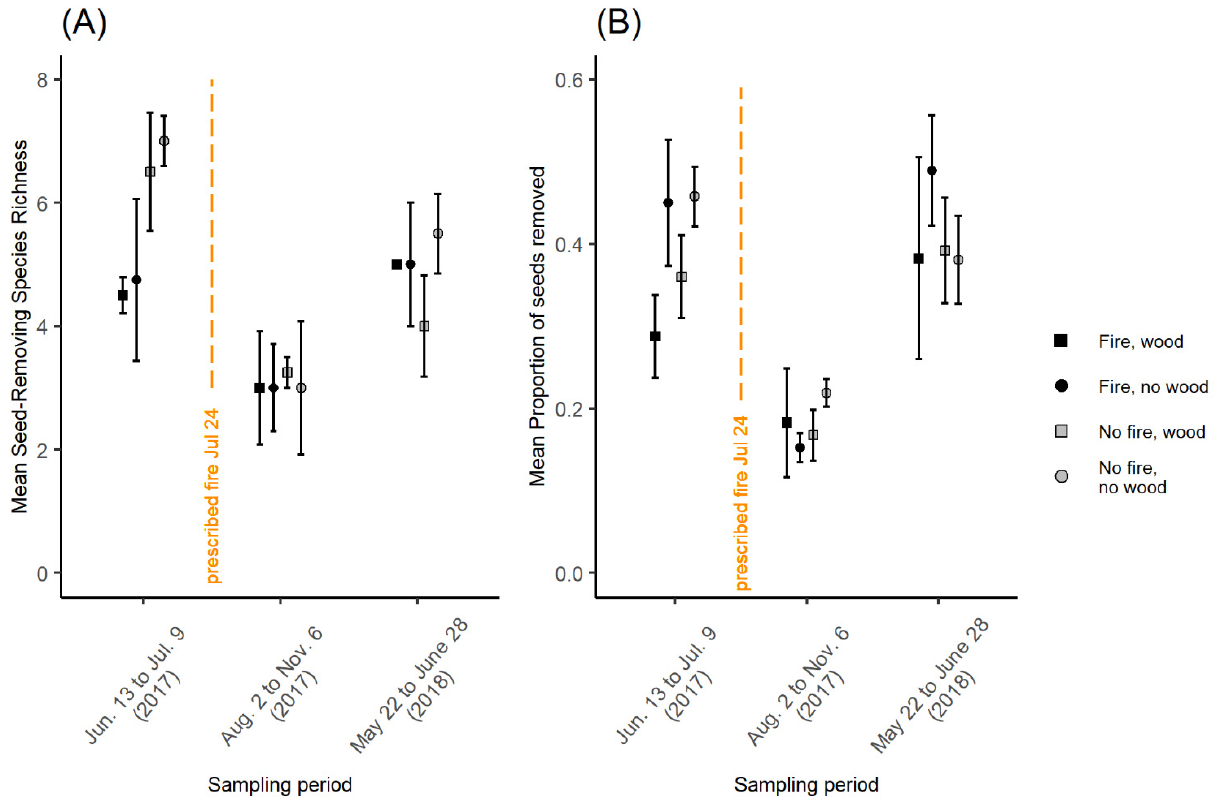
Figure 5. Sampling period effects in seed trials. Error bars are ±1 SE. ( A ) Effect on species richness. ( B ) Effect on number of seeds removed.